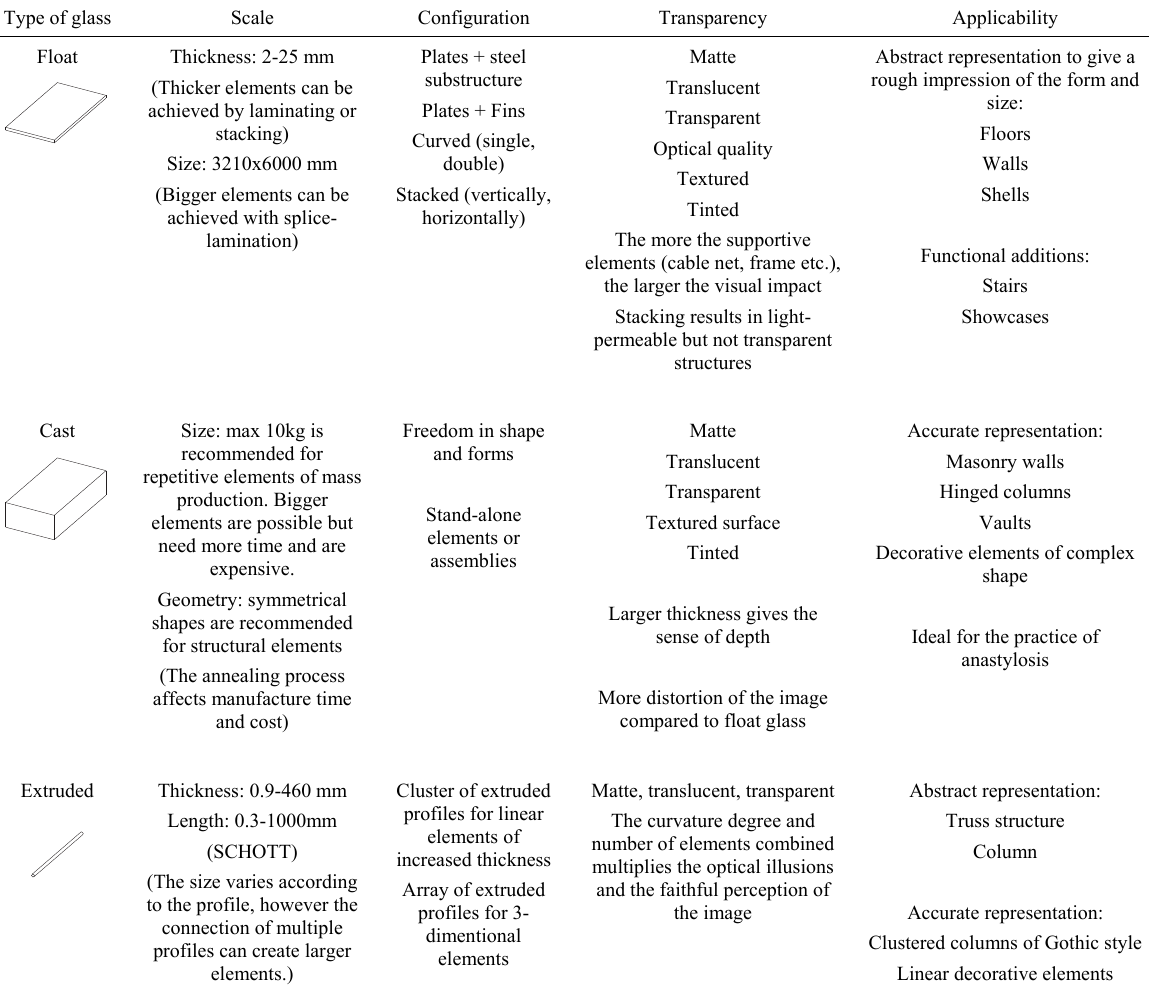
Table 3: Assessment of the different types of glass in respect to configuration, scale, transparency and applicability in restoration practices. Type of